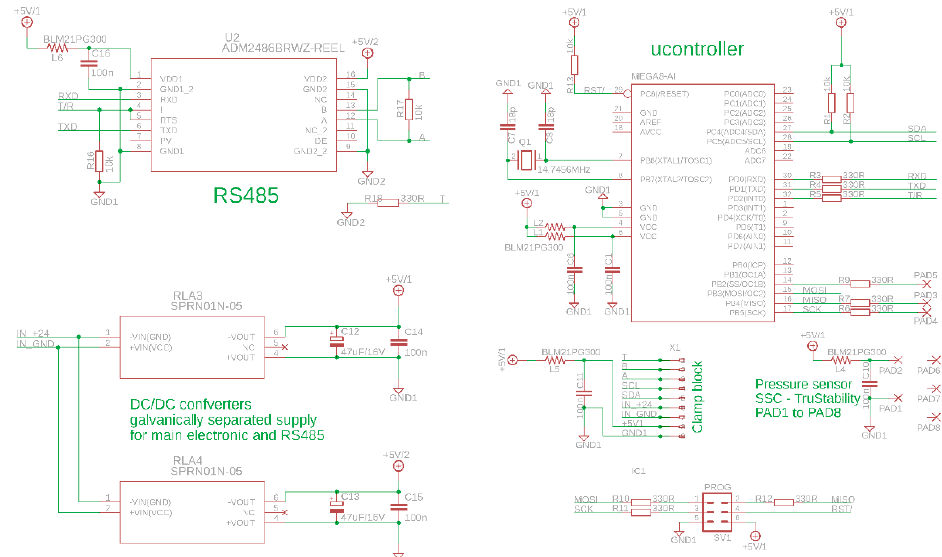
Figure 5. Electrical scheme of developed hardware.